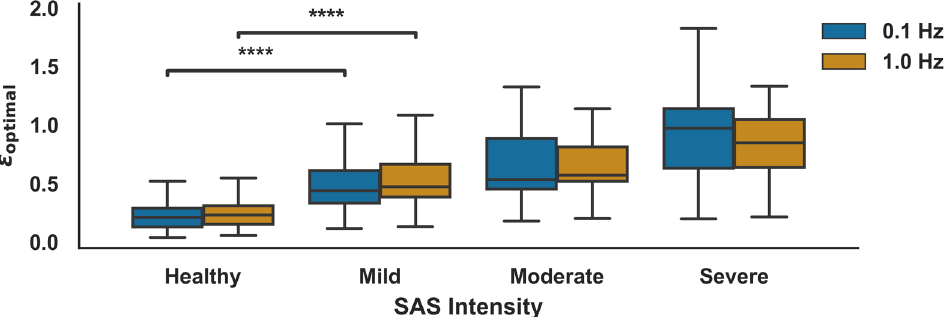
Figure 4. Boxplot with the values of ǫ opt for different SAS intensities calculated by their respective ODD value. ****p-value ≤ 0.0001 for a t-test independent sample.